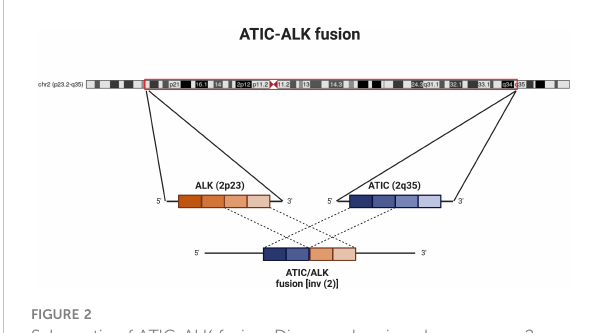
FIGURE 2 Schematic of ATIC-ALK fusion. Diagram showing chromosome 2 (courtesy of UCSC genome browser; http://genome.ucsc.edu (4); with approximate locations of ALK (2p23) and ATIC (2q35). The inversion and subsequent fusion between the 5 ’ end of ATIC to the 3 ’ end of ALK leads to activation of the ALK kinase. For our patient, the fusion is noted speci fi cally between exon 7 of ATIC and exon 20 of